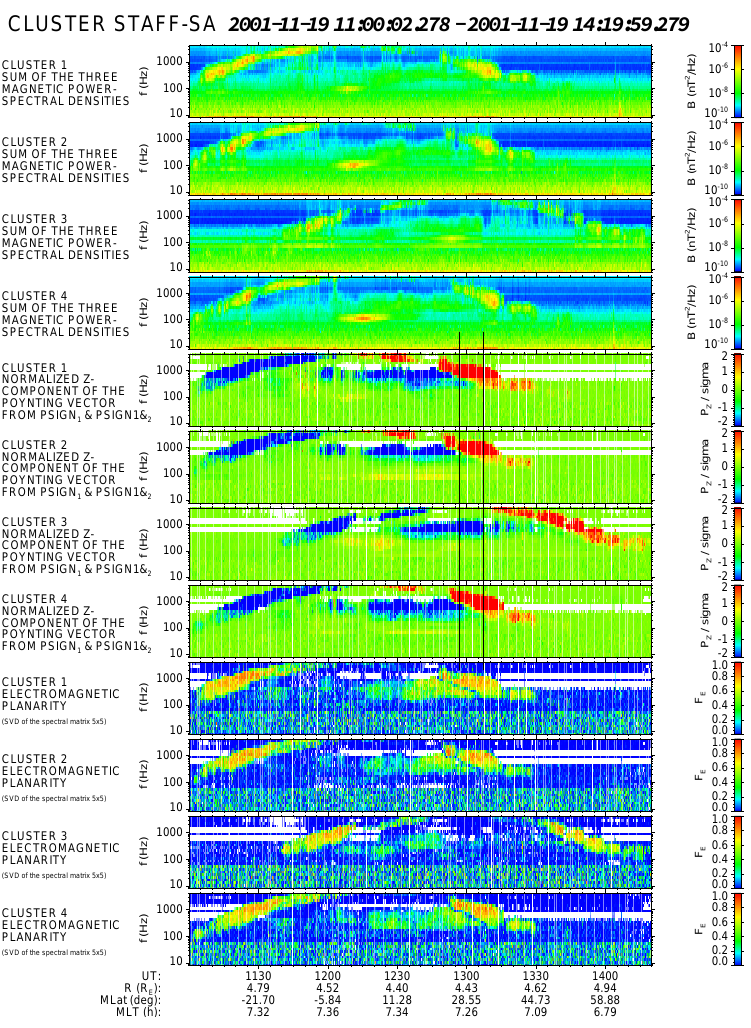
Fig. 1. Chorus event recorded on 19 November 2001 between 11:00 and 14:20UT. From the top to the bottom, spectrogram of magnetic power spectral densities, z-component of the Poynting vector and degree of planar polarization are represented for the four SC, respectively. Values are color-coded according to the scales on the right. The two vertical lines indicate the time interval where the ray tracing is done.